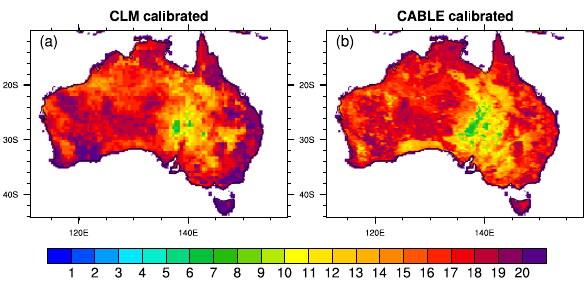
Figure 11. Twenty-class soil colour maps used for the (a) PSALB_20 and (b) PSALB_20C simulations. The corresponding saturated and dry VIS and NIR albedos for each soil colour are shown in Table